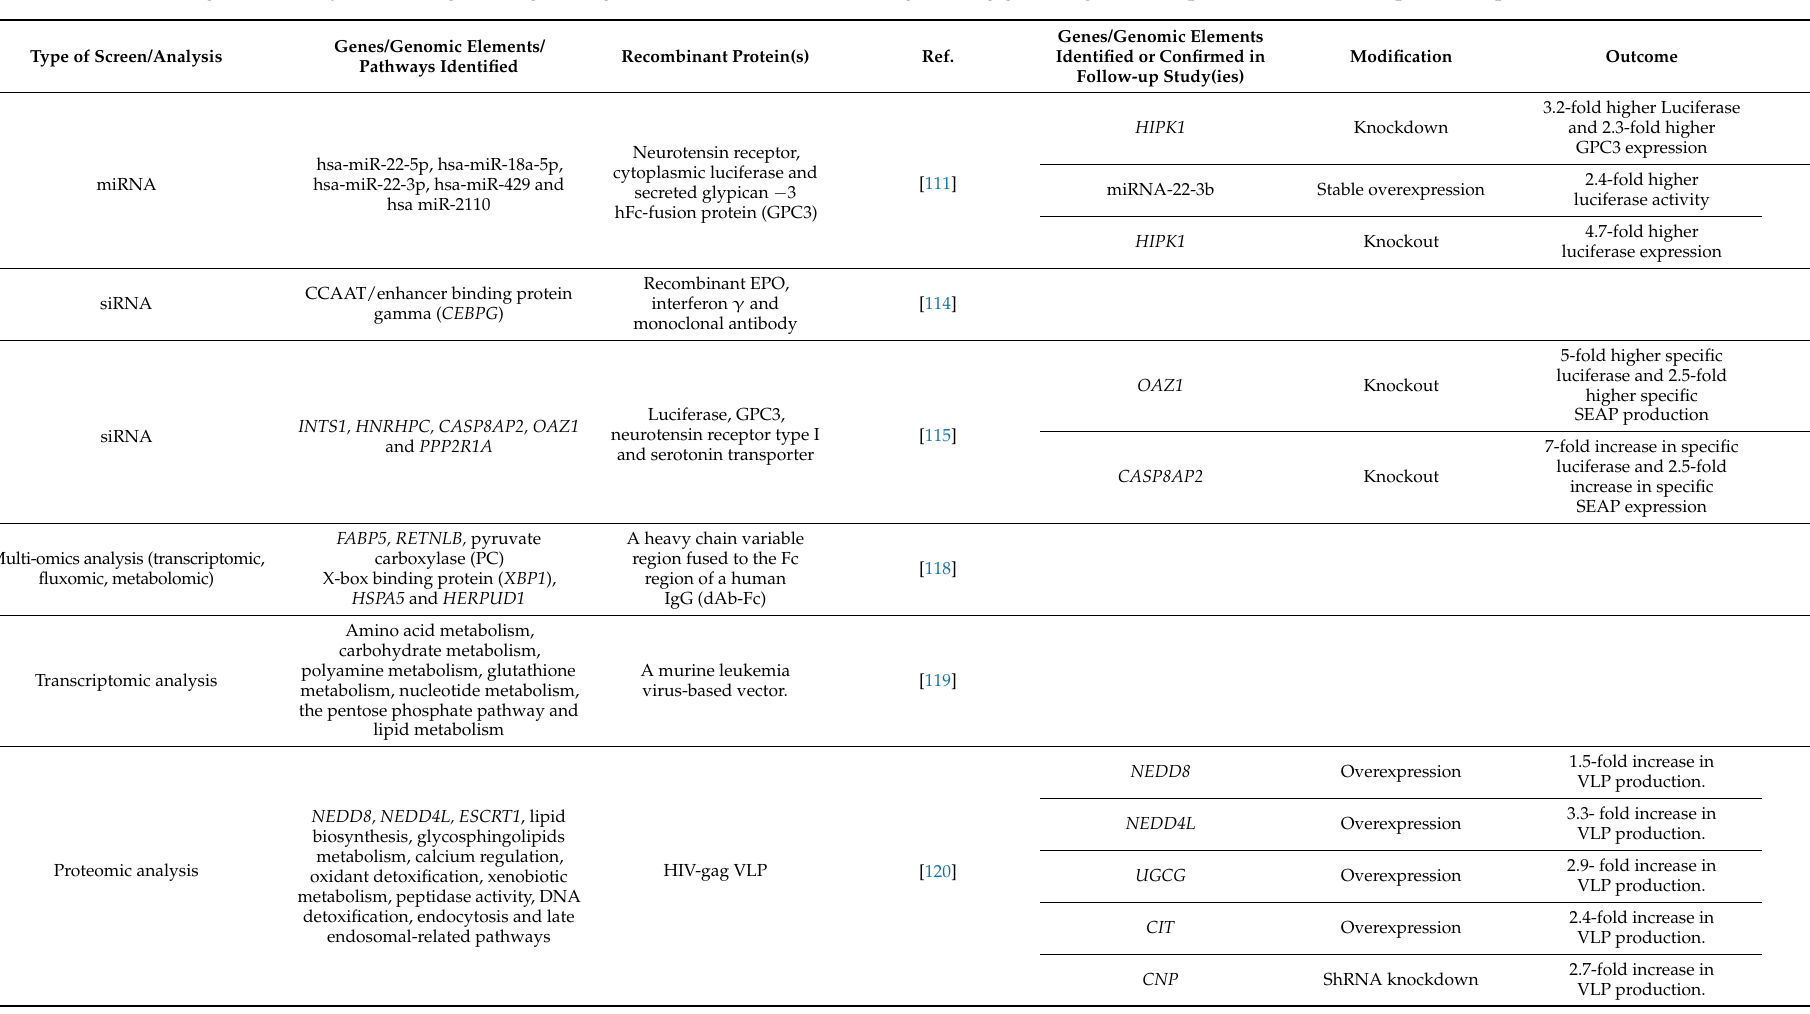
Table 8. Whole genome analyses and engineering strategies for the identification of engineering gene targets for improved recombinant protein expression in the HEK293 cell